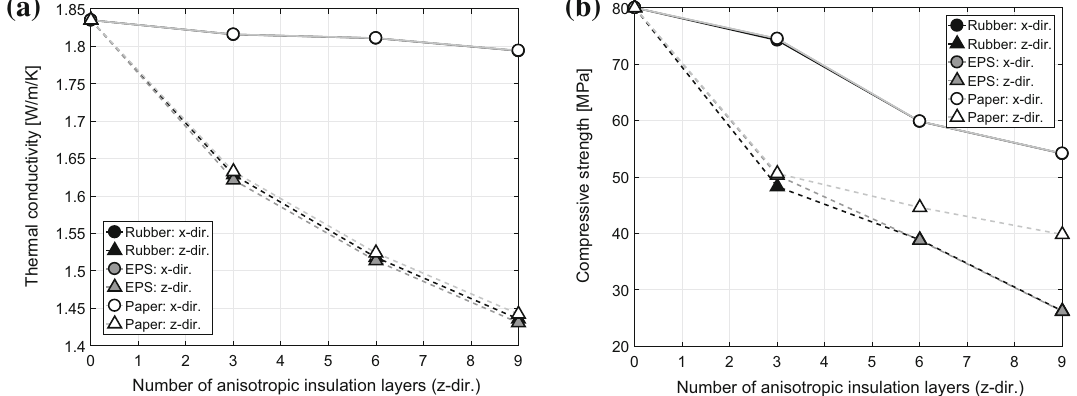
Fig. 8 Comparison of numerical material properties of the virtual insulating specimens with different insulations for the x and z directions: a Thermal conductivity, b Compressive strength.